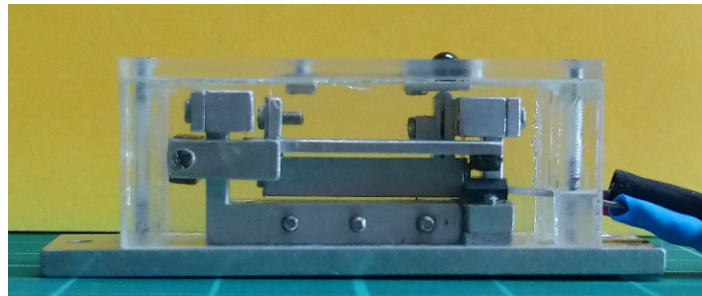
Figure 30. Design and construction of a balanced lever arm 2.